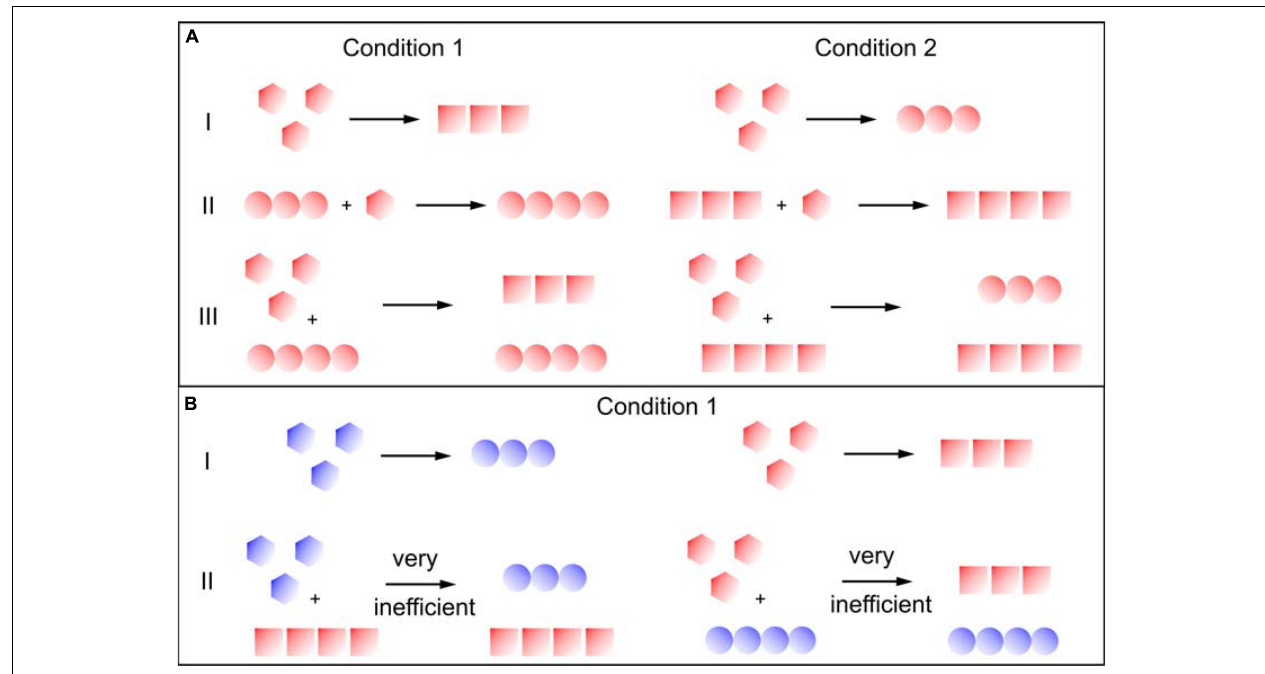
FIGURE 1 | Secondary nucleation and the transmission of structural information. Different colors indicate different sequences and different symbols indicate different structures. (A) Proteins where the same sequence can form different strains under different conditions (e.g., insulin, α -synuclein). I: Fibrils formed through primary nucleation from monomer alone form different fibril strains, depending on the solution conditions. II: In fibril elongation, the templating effect of the seed fibrils guides the monomer into a conformation that is not dictated by the solution conditions, but by the seed. III: in secondary nucleation, the newly formed fibril strains are defined by the solution conditions, rather than the seed fibrils. (B) Proteins where closely related sequences have different structural preferences (e.g., A β 1-40 and A β 1-42). I: the related sequences may form different fibrils even under identical solution conditions. II: Cross-surface nucleation can be inefficient if the monomers have a different structural preference from the seed